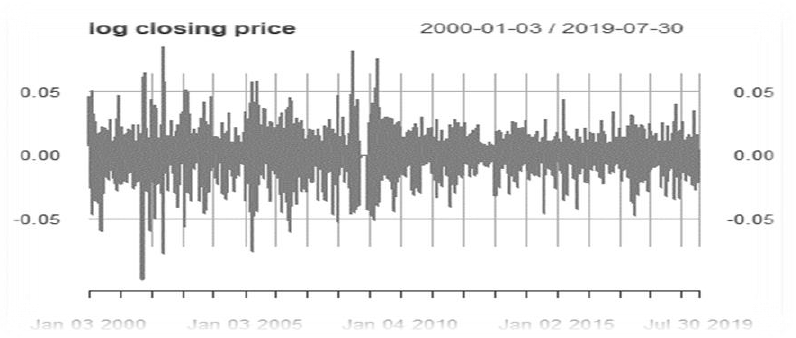
Figure.2. Log Closing Price of KSE-100